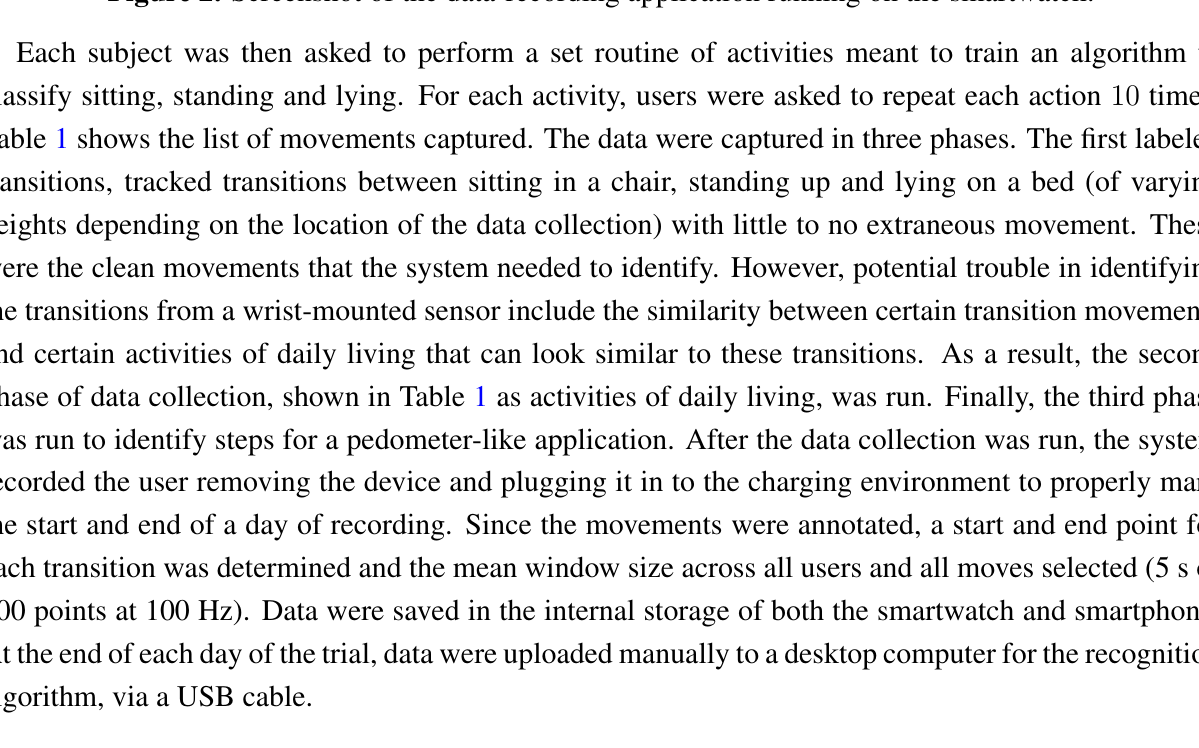
Figure 2. Screenshot of the data-recording application running on the